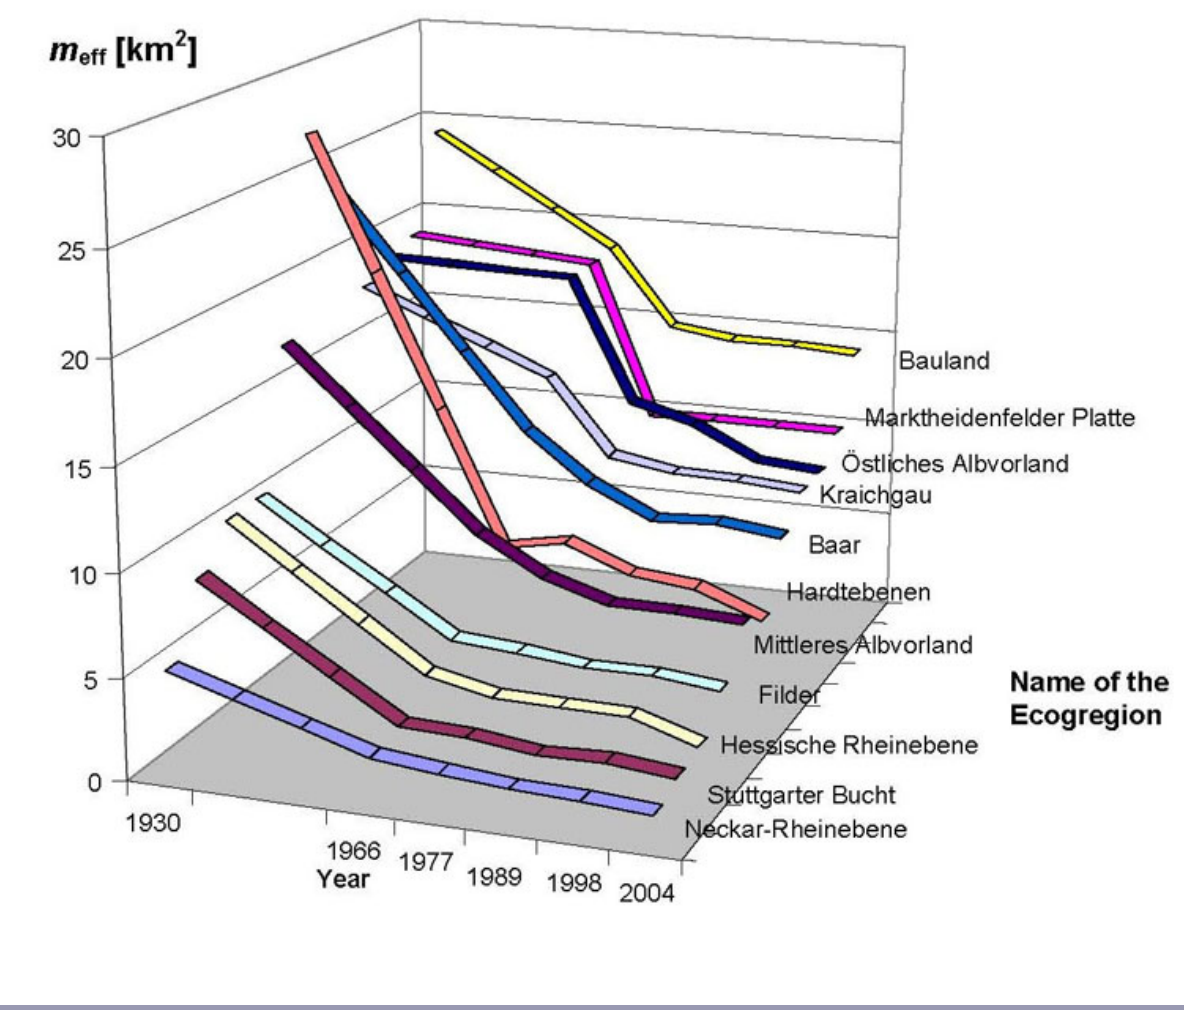
Fig. 8. Some examples of time series of the degree of landscape fragmentation within the ecoregions in Baden-Württemberg from 1930 to 2004 in terms of effective mesh size ( m excluding municipal roads). (The location of the ecoregions within Baden-Württemberg is shown in Fig.